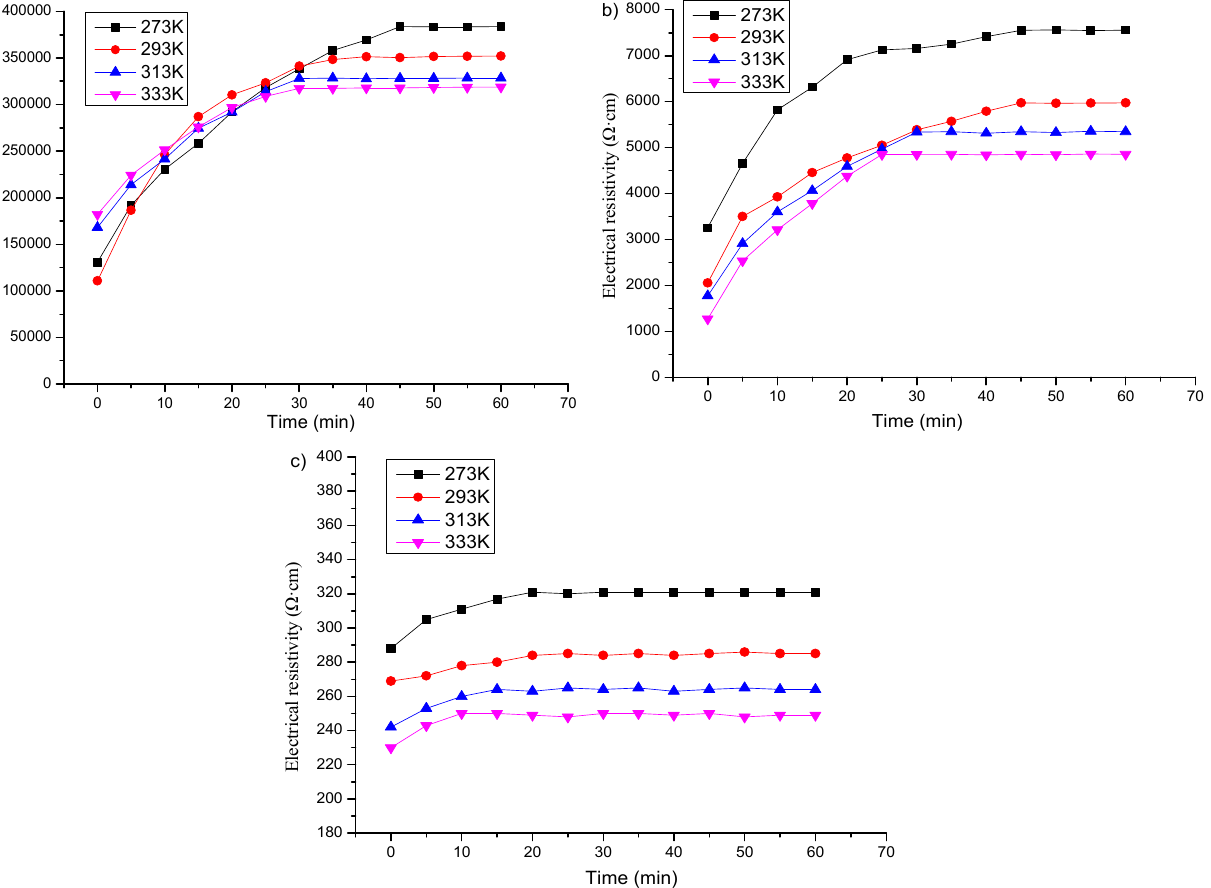
Figure 13. Influence of temperature on polarization effect of specimens with different graphene contents after freeze–thaw: ( a ) 1%; ( b ) 2%; ( c ) Table 8. Polarization time of specimens with different graphene contents after freeze–thaw at dif- ferent temperature.